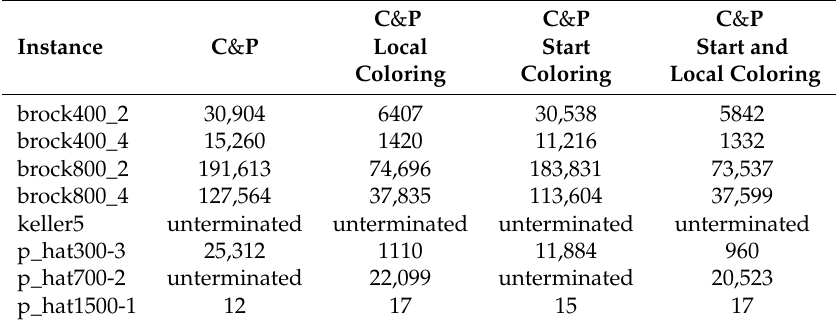
Table 1. Comparison of run times (in seconds) for four exact algorithms for the maximum clique problem.